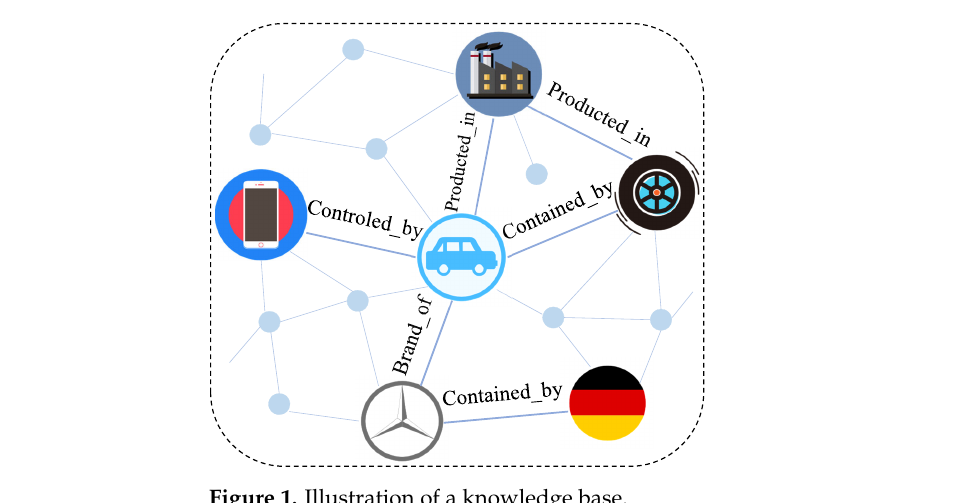
Figure 1. Illustration of a knowledge